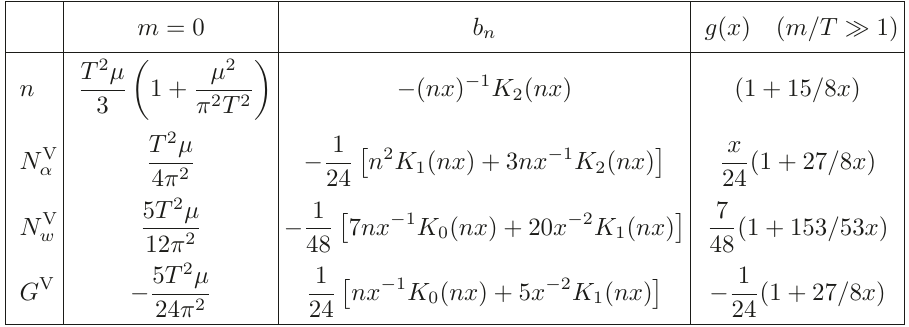
Table 4 . The vector current coefficients (6.3) for an ideal Dirac field: the first column is the result at m = 0, the second column is the generic terms of the series expansion (8.4), the third column is the asymptotic expansion for low temperature